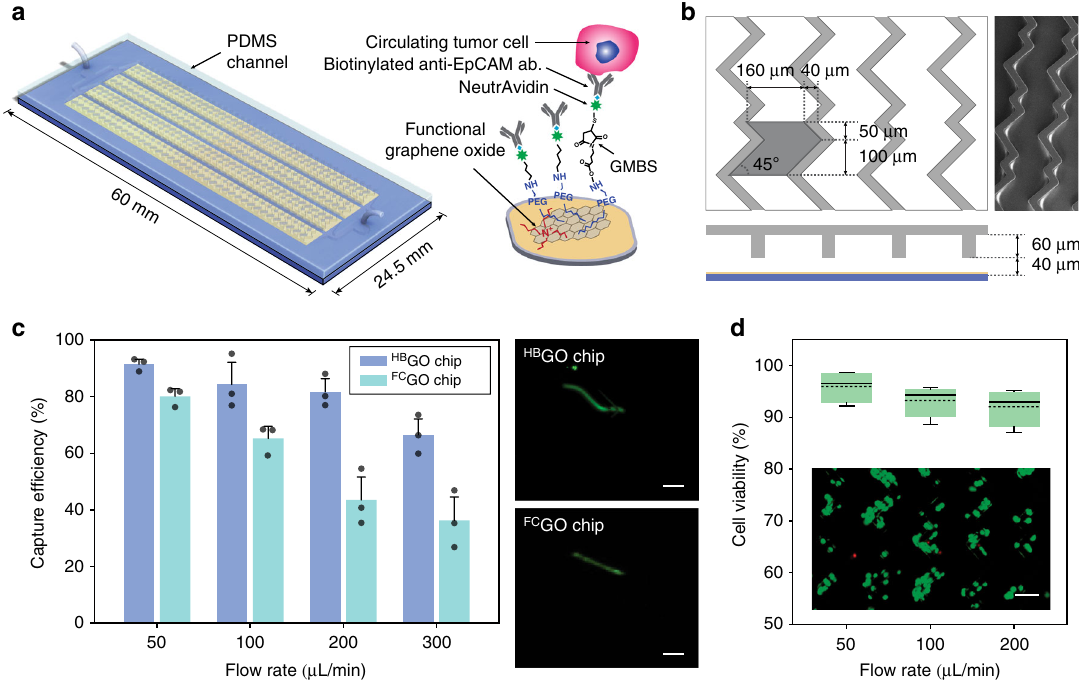
Fig. 2 Ex vivo evaluation of HB GO chip for CTC capture. a Schematic of the HB GO chip and the conjugation chemistry between functional graphene oxide and anti-EpCAM antibody. b Schematic and micrograph of the herringbone grooved channel geometry. c CTC isolation performance of the HB GO chip compared with the FC GO chip (data points are means± s.d., n = 3). A fl uorescent labeled single MCF7 cell traveling within the two different channels shows difference in cell trajectory. d Measure of cell viability as a function of fl ow rate after capture (dotted line is the mean, n = 4). Inset: fl uorescence microscope image of MCF7 cells stained with live/dead assay. Viable cells are shown in green. All scale bars represent 100 µ m. Source data are available in the Source Data fi